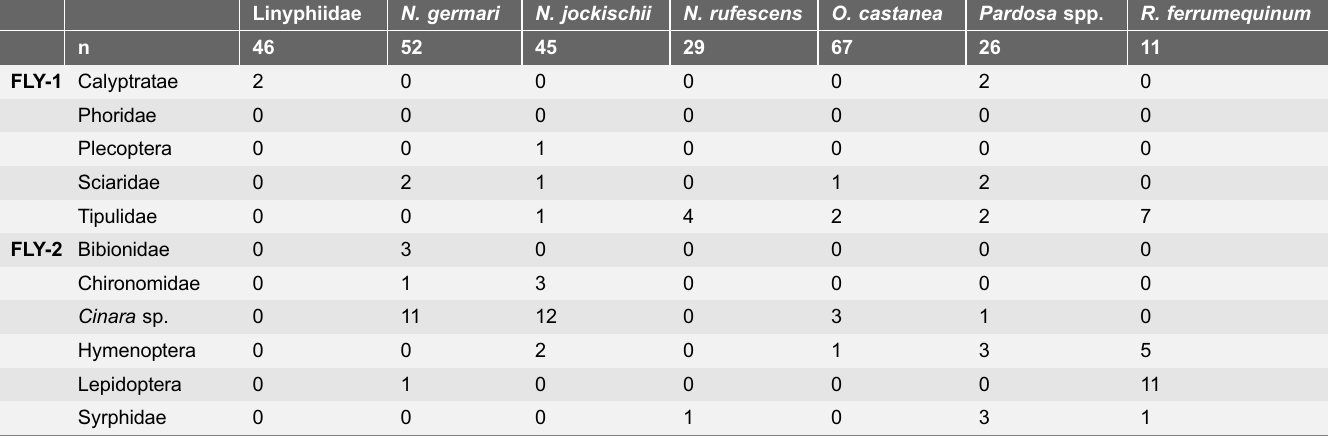
Table 2. Detection of flying insect prey DNA within dietary samples of different consumers (Linyphiidae, Pardosa spp.: whole body samples; Nebria germari , N. jockischii , N. rufescens , Oreonebria castanea : regurgitates; Rhinolophus ferrumequinum : faecal samples) when tested with the newly developed multiplex PCR systems FLY-1 and FLY-2.